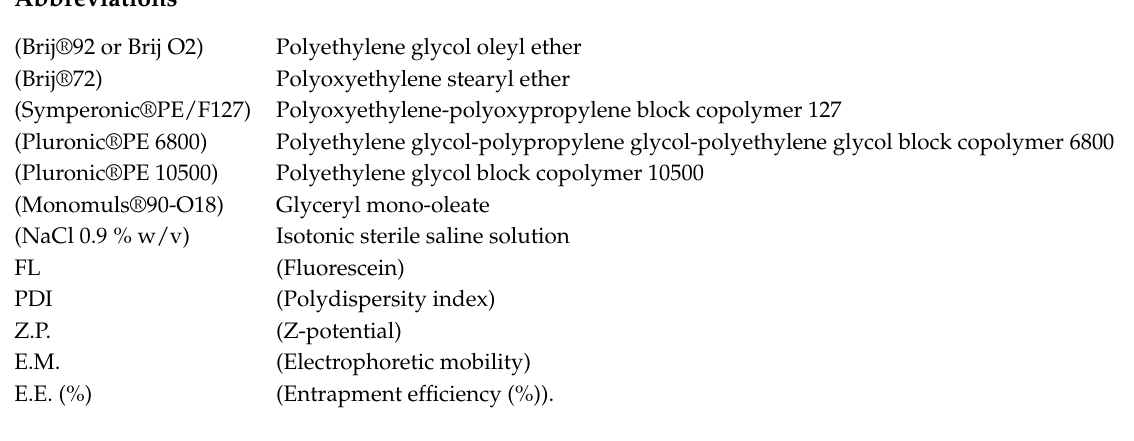
Figure S1: t -test applied to compare the linear regression for square root equation for formulations 1, 3, 4, and 5; Equations